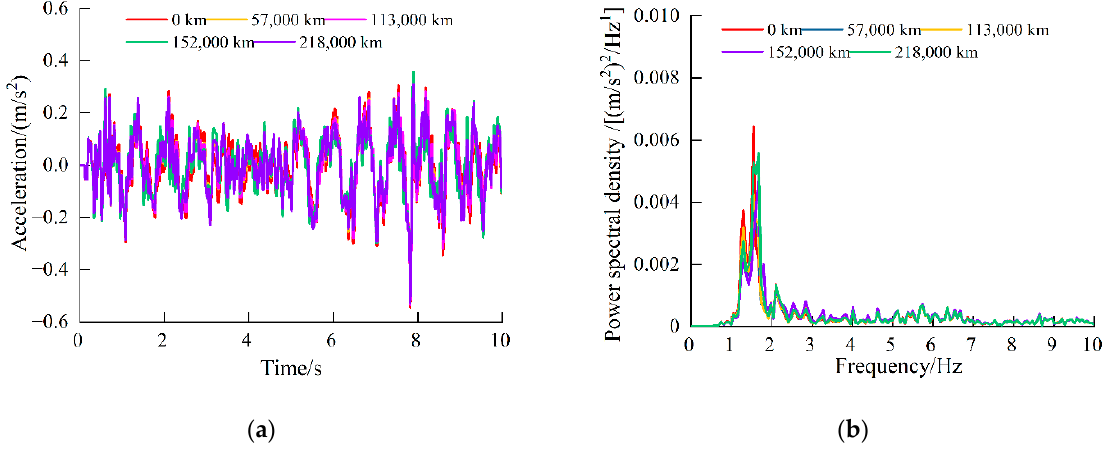
Figure 13. Vibration on carbody ends for Line B: ( a ) time ‐ domain and ( b ) frequency ‐ domain.